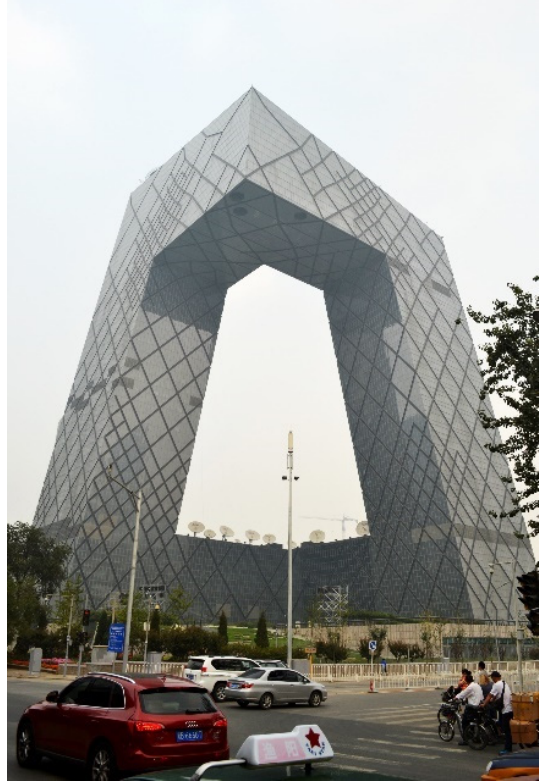
Figure 25. CCTV Building (2008) in Beijing, China by OMA. It is an example of an innovative diagrid system that improves structural performance and produces “exotic” forms. (Photo by K. Al-Kodmany).